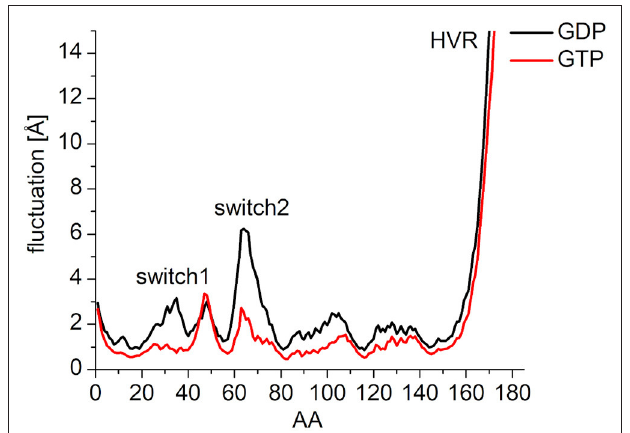
FIGURE 4 | RMS fluctuation of C α atoms on MDeNM generated conformations of GDP- (black) and GTP-bound (red) K-Ras4B. For the better visualization of the catalytic domain regions the y-axis is enlarged up to and cropped at 15 Å.